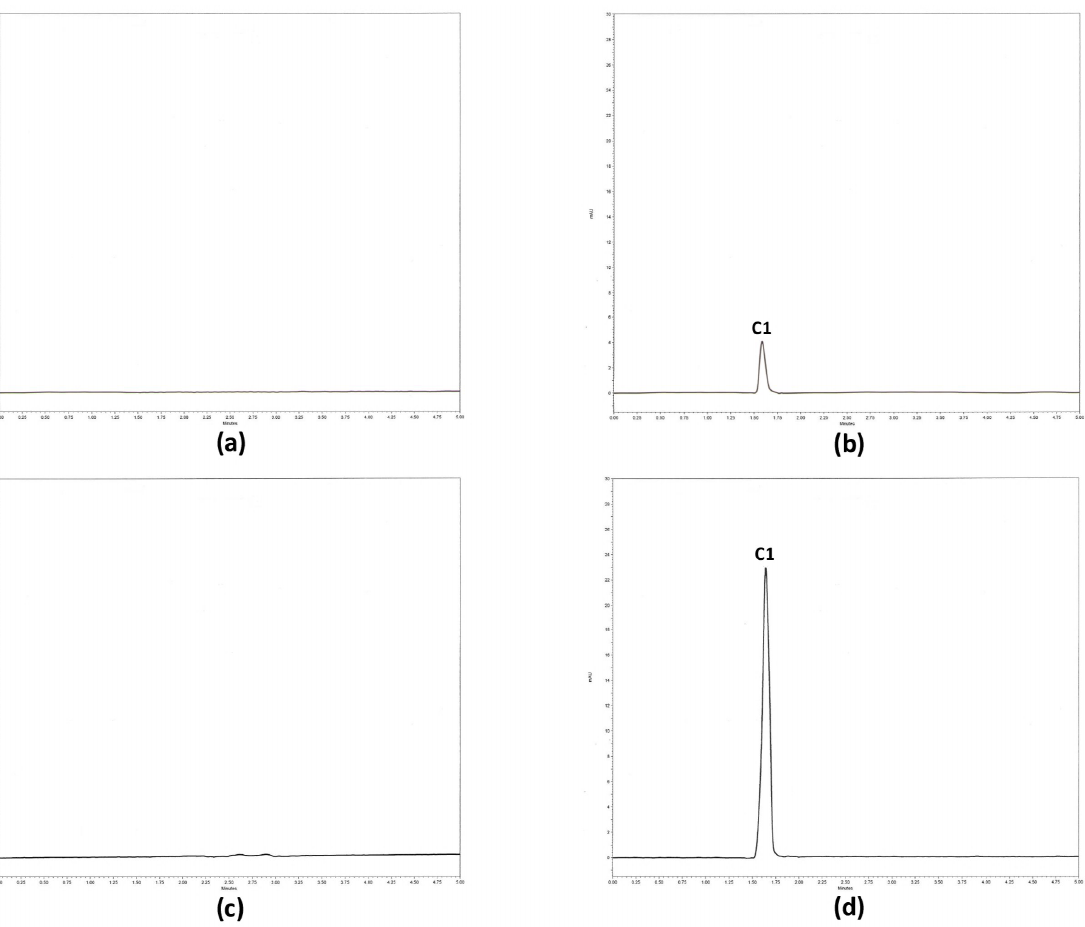
Figure 3. Selectivity chromatograms. The selectivity parameter was evaluated by the RP-HPLC method in the following samples: ( a ) biological matrix-plasma, ( b ) 1 µ g/mL of C1 as a standard, ( c ) a biological matrix enriched with ketamine, xylazine, and heparin, and ( d ) an in vivo plasma sample from a rat administered C1